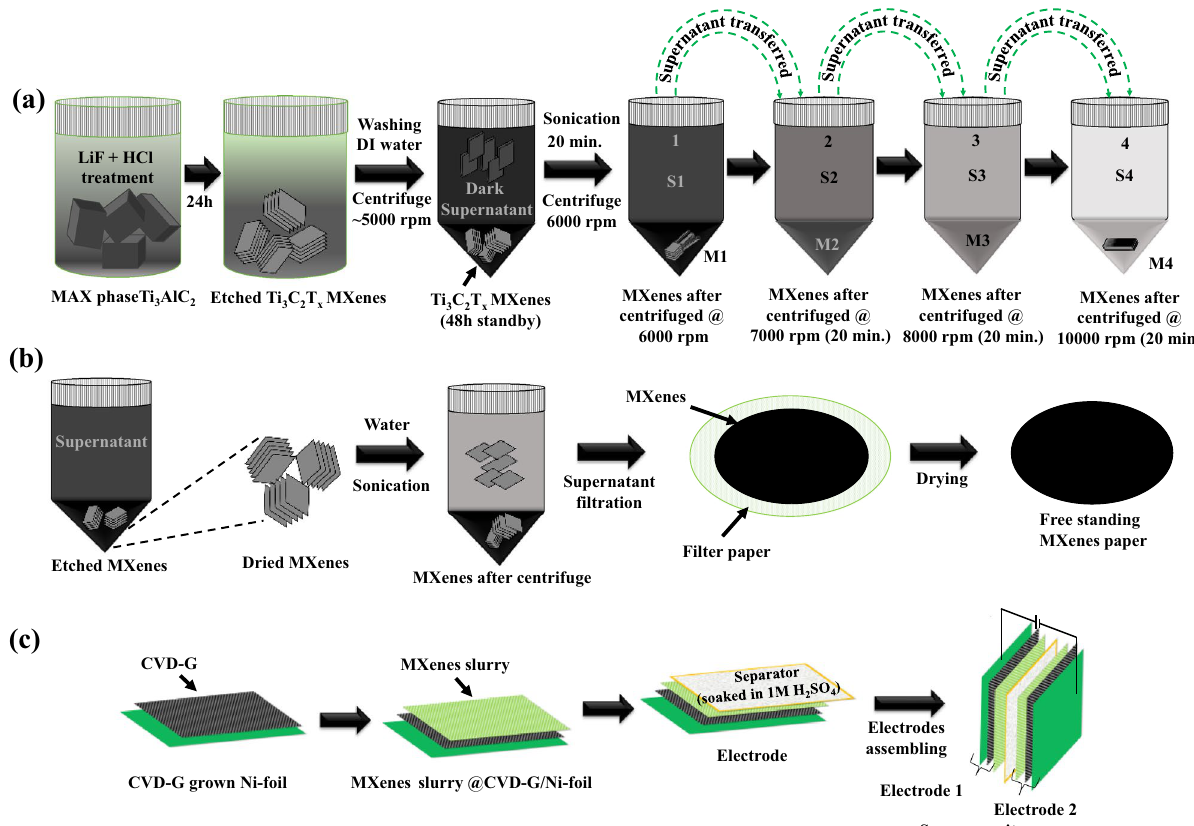
Figure 1. Ti 3 C 2 T x MXene ( a ) synthesis from the supernatant by subsequent transfer in this study, ( b ) MXene synthesis in earlier studies for comparison, and ( c ) supercapacitor fabrication